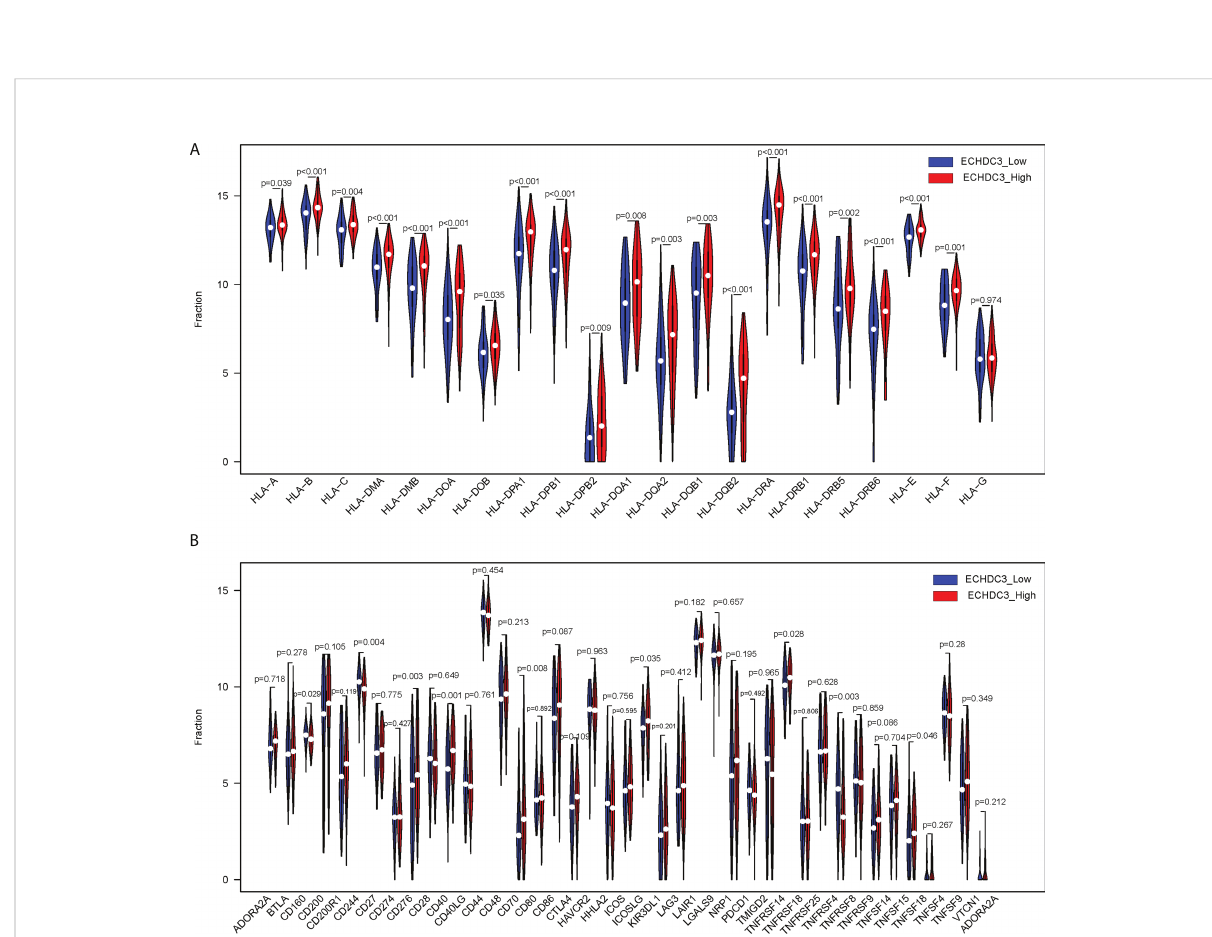
FIGURE 7 Comparison of HLA gene expression and immune checkpoint gene expression between ECHDC3 high and low subgroup. (A) HLA gene expression in ECHDC3 high and low subgroups. (B) Immune checkpoint gene expression in ECHDC3 high and low subgroups.